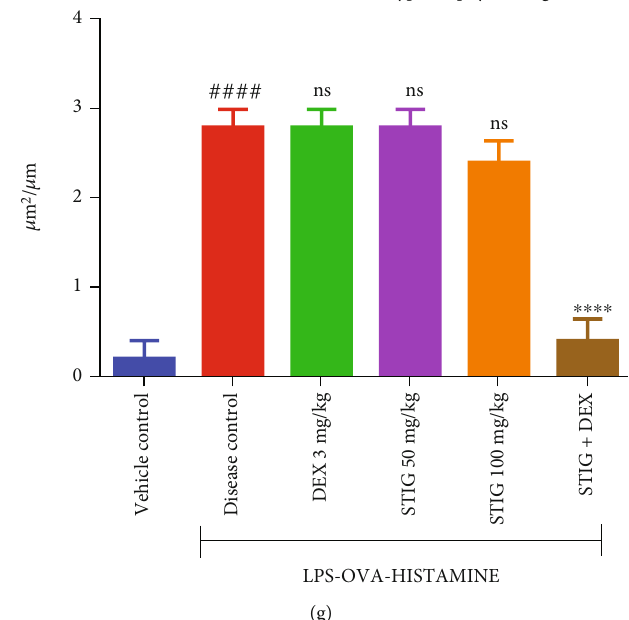
Figure 7: E ff ect of STIG and STIG+DEX on smooth muscle hypertrophy and basement membrane thickening. Lung tissues were assessed for bronchial basement membrane thickening (BM) and airway smooth muscle hyperplasia (SM) ( magnification = × 40 ). Morphometric analysis quanti fi ed the extent of smooth muscle hypertrophy ( g ). Data is expressed as mean index ± SEM ( n = 5 ). #### p < 0 : 0001 compared to the vehicle control group; ∗∗∗∗ p < 0 : 0001 and ns (not signi fi cant) as compared to the disease control group using ANOVA followed by Dunnett ’ s post hoc test